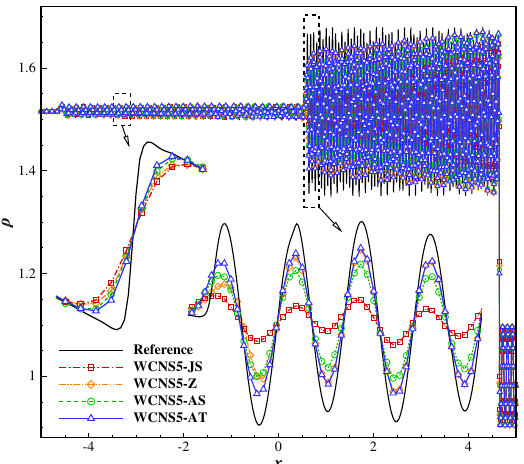
Figure 15. Density distribution of Titarev-Toro